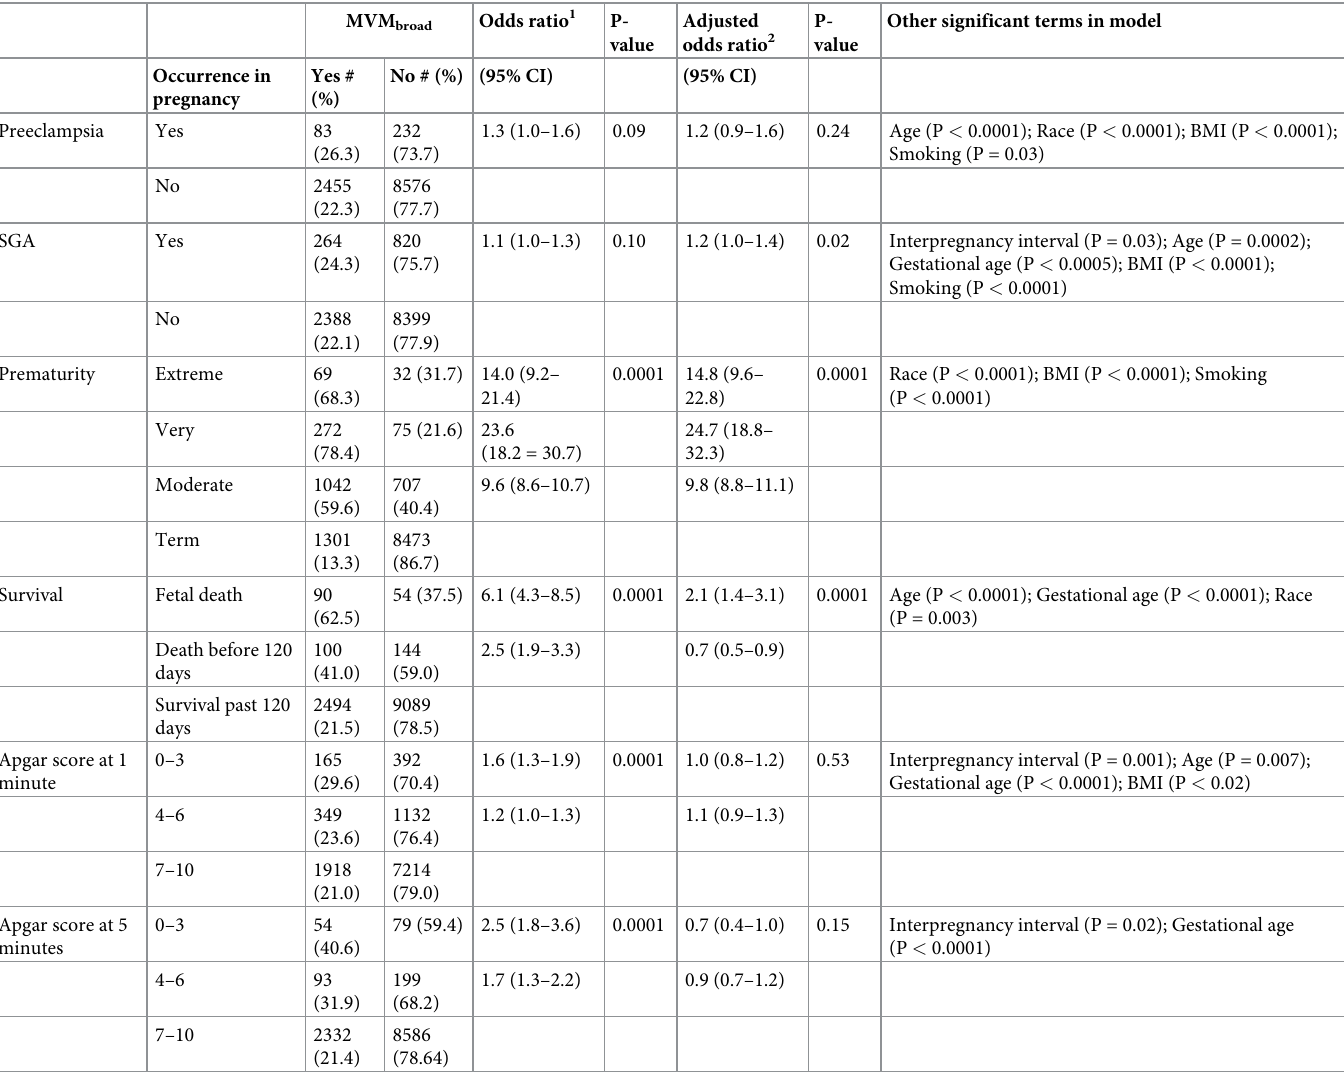
Table 5. Associations between MVM broad lesions and pregnancy